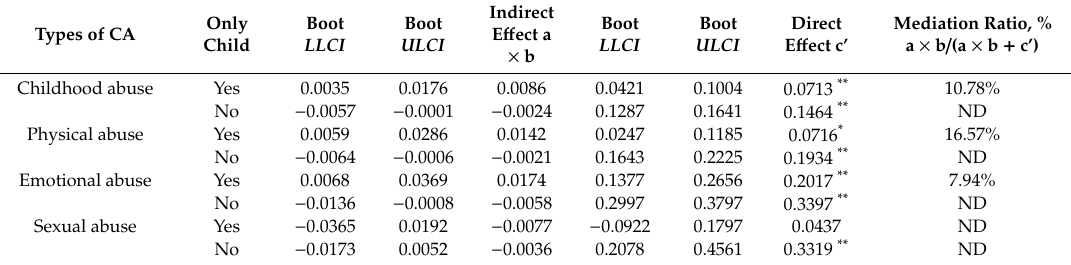
Table A2. Childhood abuse - social support from family and relatives -